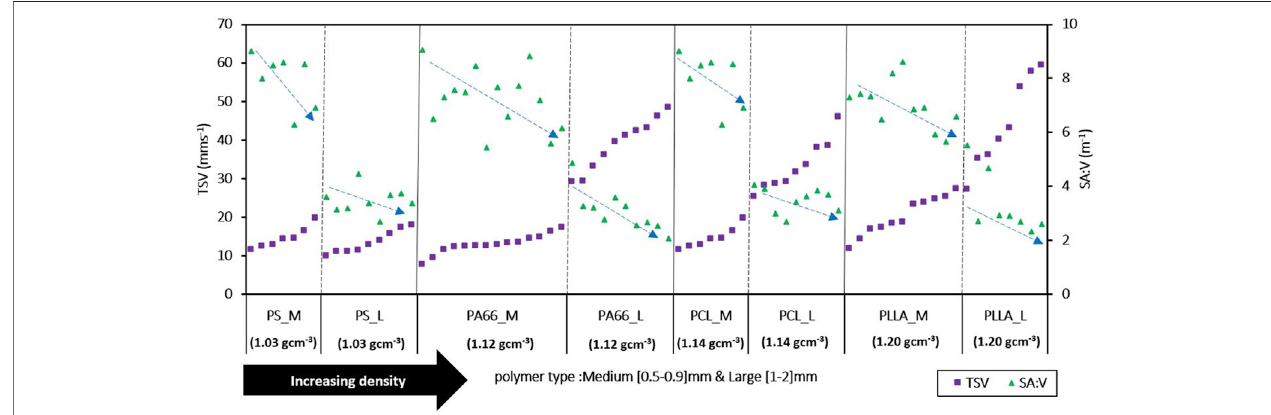
FIGURE8| SimulatedTSVs(leftaxis)andcalculatedSA:V(rightaxis)forthe75irregularMPparticles.Thedifferentpolymersarearrangedintheorderofincreasing density along the x-axis with their equivalent diameters being grouped into intervals of 0.5 – 0.9 mm (Medium, e.g., PS-M) and 1 – 2 mm (Large, PS-L). The TSVs in each subsetofparticles ofaparticular polymer (e.g.,PS_M orPS_L)werearrangedinincreasingorderfromleft toright. Theblue dashed arrows indicate thegeneraldirection of the trend in SA:V over an increasing